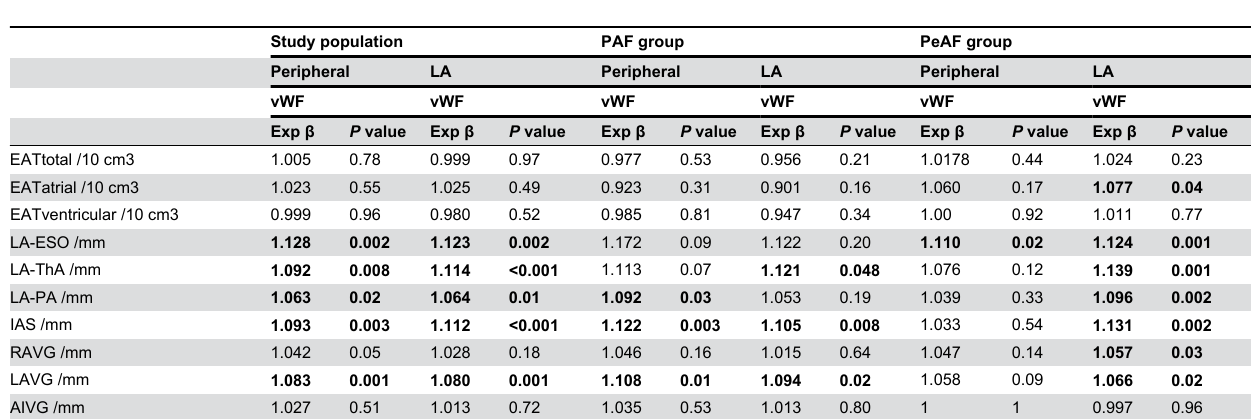
Table 5. Multivariable Models with Peripheral and LA Blood Levels of vWF as the Dependent